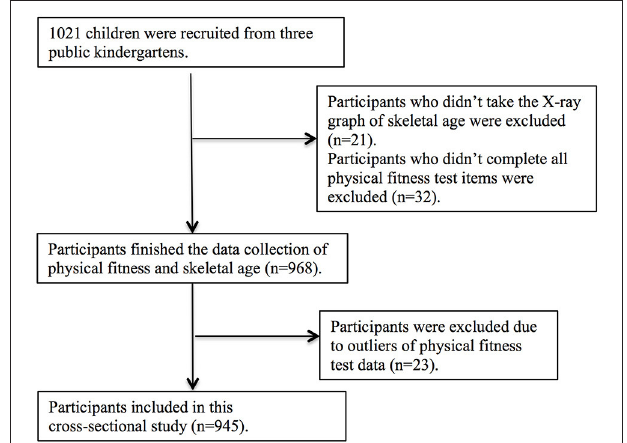
FIGURE 1 | Flowchart of sample selection